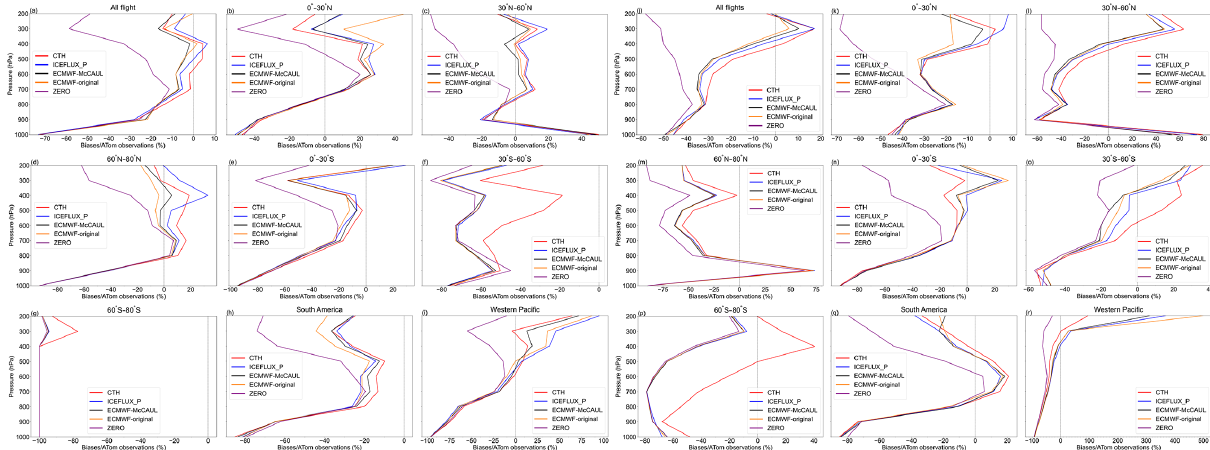
Figure 7. Vertical profile of biases divided by the ATom1 observations (a–i) and the vertical profile of biases divided by the ATom2 observa- tions (j–r) . The bias is the model bias (NO) against ATom observations (NO). Data for each pressure level P are calculated within the range of P ± 50hPa. South America is the region of 0–30 ◦ S, 0–30 ◦ W. The western Pacific is the region of 10 ◦ N–30 ◦ S, 160 ◦ E–160 ◦ W. Table 3. Model biases (NO) when compared against ATom1 (a) and ATom2 (b) . The unit is parts per trillion (ppt). The biases within